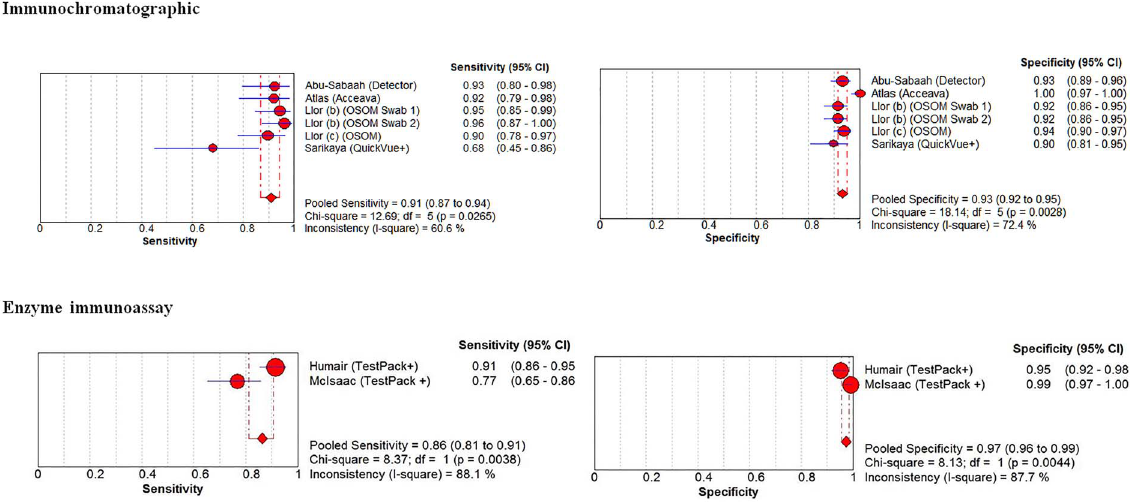
Figure 5. Adult strata, forest plots for immunochromatographic (top panels), enzyme immunoassay (EIA, middle panels) and optical immunoassay (OIA, bottom panels) methods to diagnose group A streptococcal pharyngitis, higher study methodological quality.